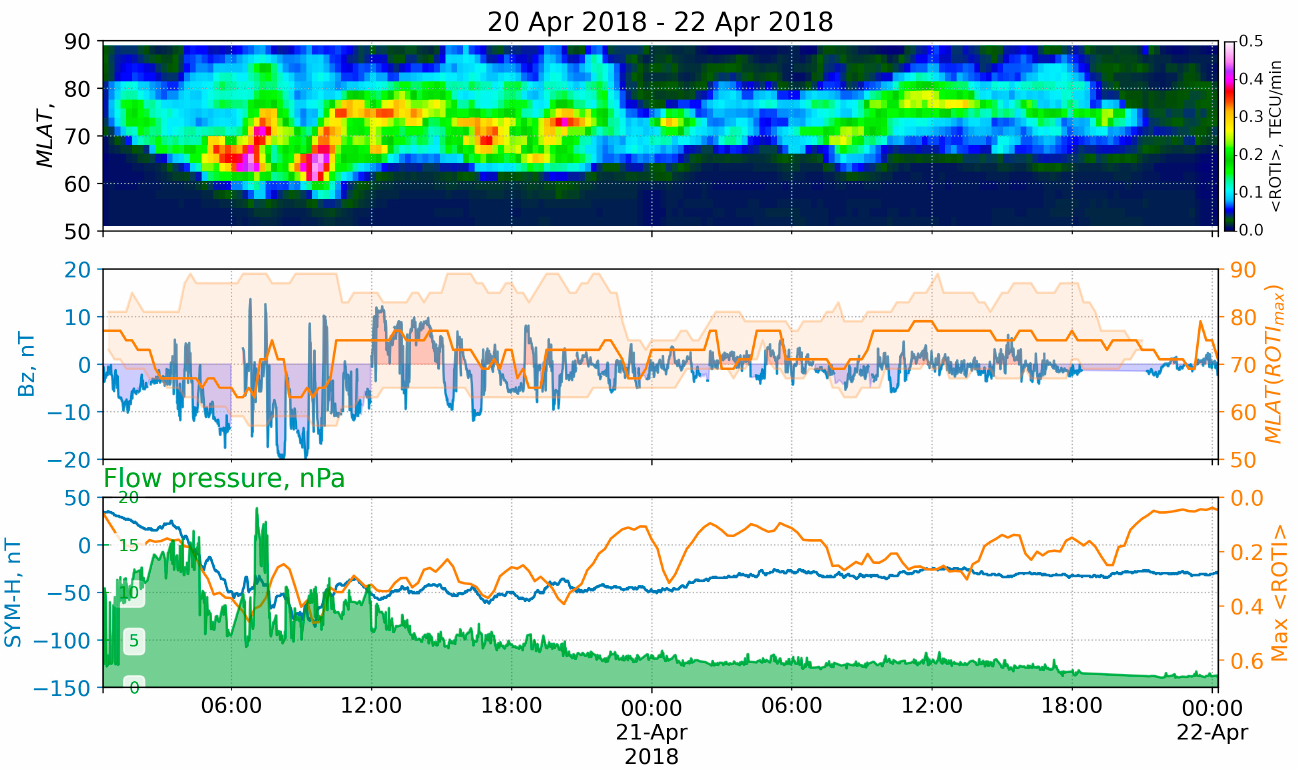
Figure 8. ROTI keogram and space weather parameters for the storm of 20 April 2018: ( top ) keogram of average ROTI (<ROTI> versus MLAT versus time); ( middle ) IMF Bz ( blue ), MLAT positions of maximum <ROTI> ( orange ), and values exceeding median ROTI at the moment ( orange filling ); ( bottom ) SYM-H index ( blue ), <ROTI> max ( orange ), and flow pressure ( green ).